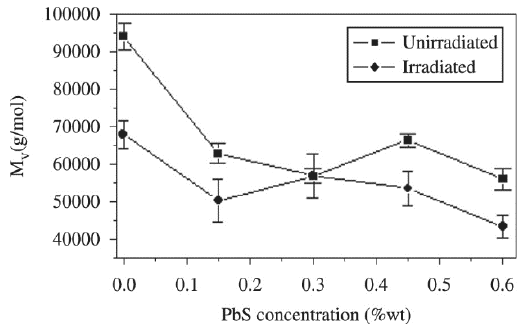
Figure 3. Viscosity molar mass (M PbS-NP concentration.